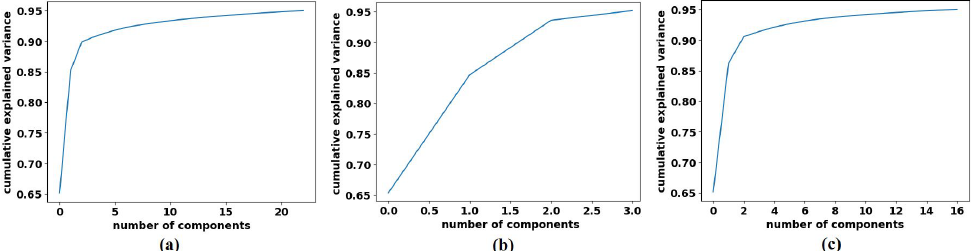
Figure 6. The explained variance of the principal components for each class in the CRC dataset: